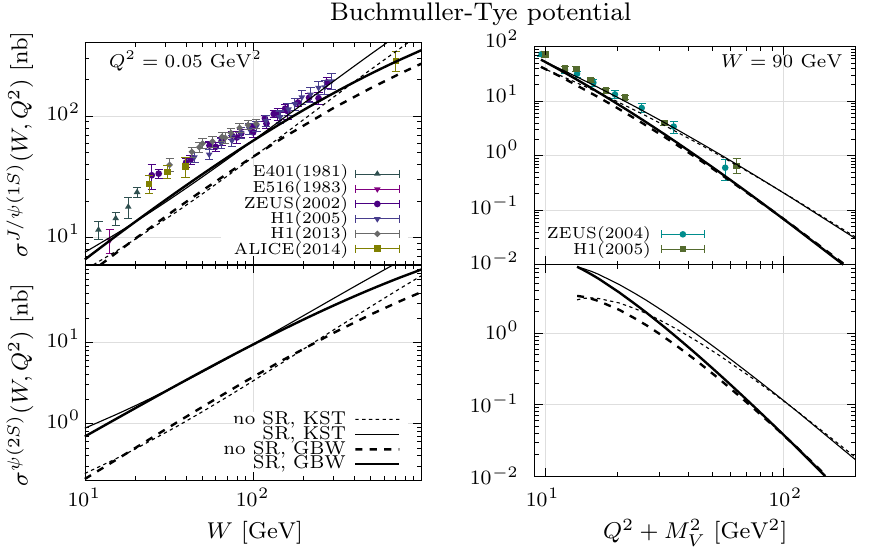
Fig. 3 Predictions for the elastic photoproduction cross section of the lower box) at fixed c.m. energy W = 90 GeV. The data of the process γ ∗ p → J /ψ( 1 S ) p are taken from Refs. [44,47]. All model predic- process γ p → J /ψ( 1 S ) p (left upper box) and γ p → ψ (cid:2) ( 2 S ) p (left lower box) with almost real photon ( Q 2 = 0 . 05 GeV 2 ) as a function tions have been performed with the wave functions of J /ψ( 1 S ) and ψ (cid:2) ( 2 S ) using the realistic Buchmüller–Tye potential [31]. The solid of c.m. energy W of the photon-proton system. The corresponding data are taken from Refs. [41–46]. Predictions for the elastic virtual pho- and dashed curves represent the model calculations with and without toproduction cross section of the process γ ∗ p → J /ψ( 1 S ) p (right effects of the Melosh spin rotation, respectively. The thin and thick curves corresponds to calculations using the phenomenological KST upper box) and γ ∗ p → ψ (cid:2) ( 2 S ) p (right lower box) as a function of the [35] and GBW [39] dipole cross section, respectively photon virtuality Q 2 + M 2 (right upper box) and Q 2 + M 2 ψ (cid:2) (right J /ψ Fig. 4 The same as Fig. 3 but with the wave functions of J /ψ( 1 S ) and ψ (cid:2) ( 2 S ) states Q 2 = 0 . 05 GeV obtained by using the realistic power-like potential [32]